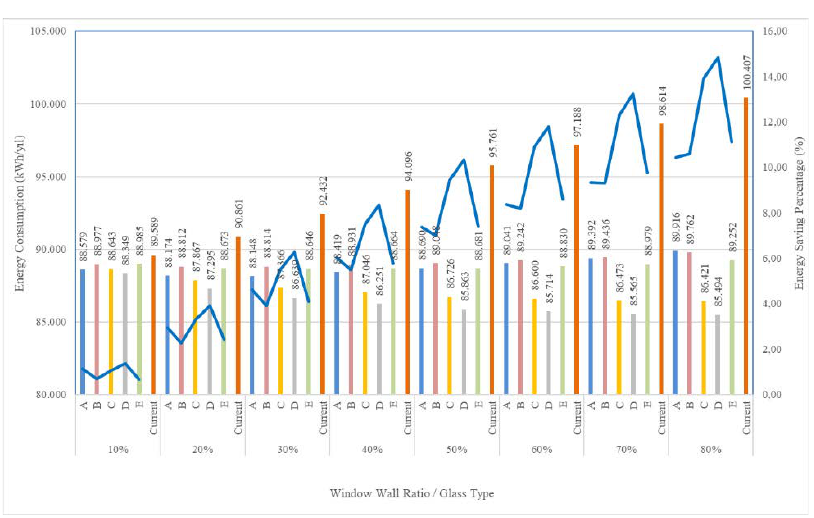
Figure 14 Energy saving rates, calculated energy consumptions and reference energy consumptions for